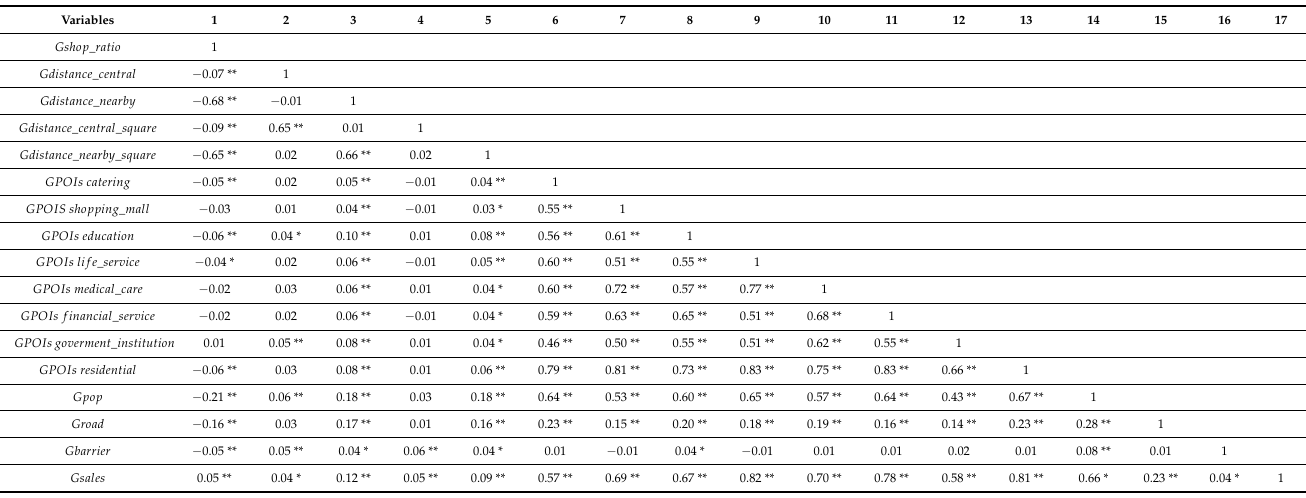
Table 2. Correlations among the